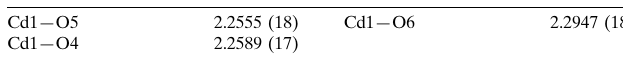
Selected bond lengths (A˚ ).